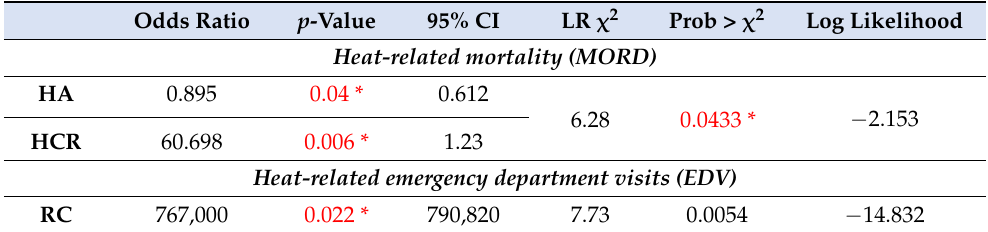
Table 8. Logistic regression model for heat-related mortality (MORD) and heat-related emergency department visits